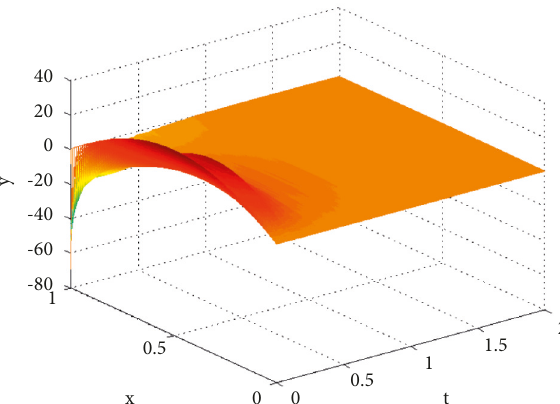
Figure 3: A sample path of the solution u ( x,t ) to equation (29) with control